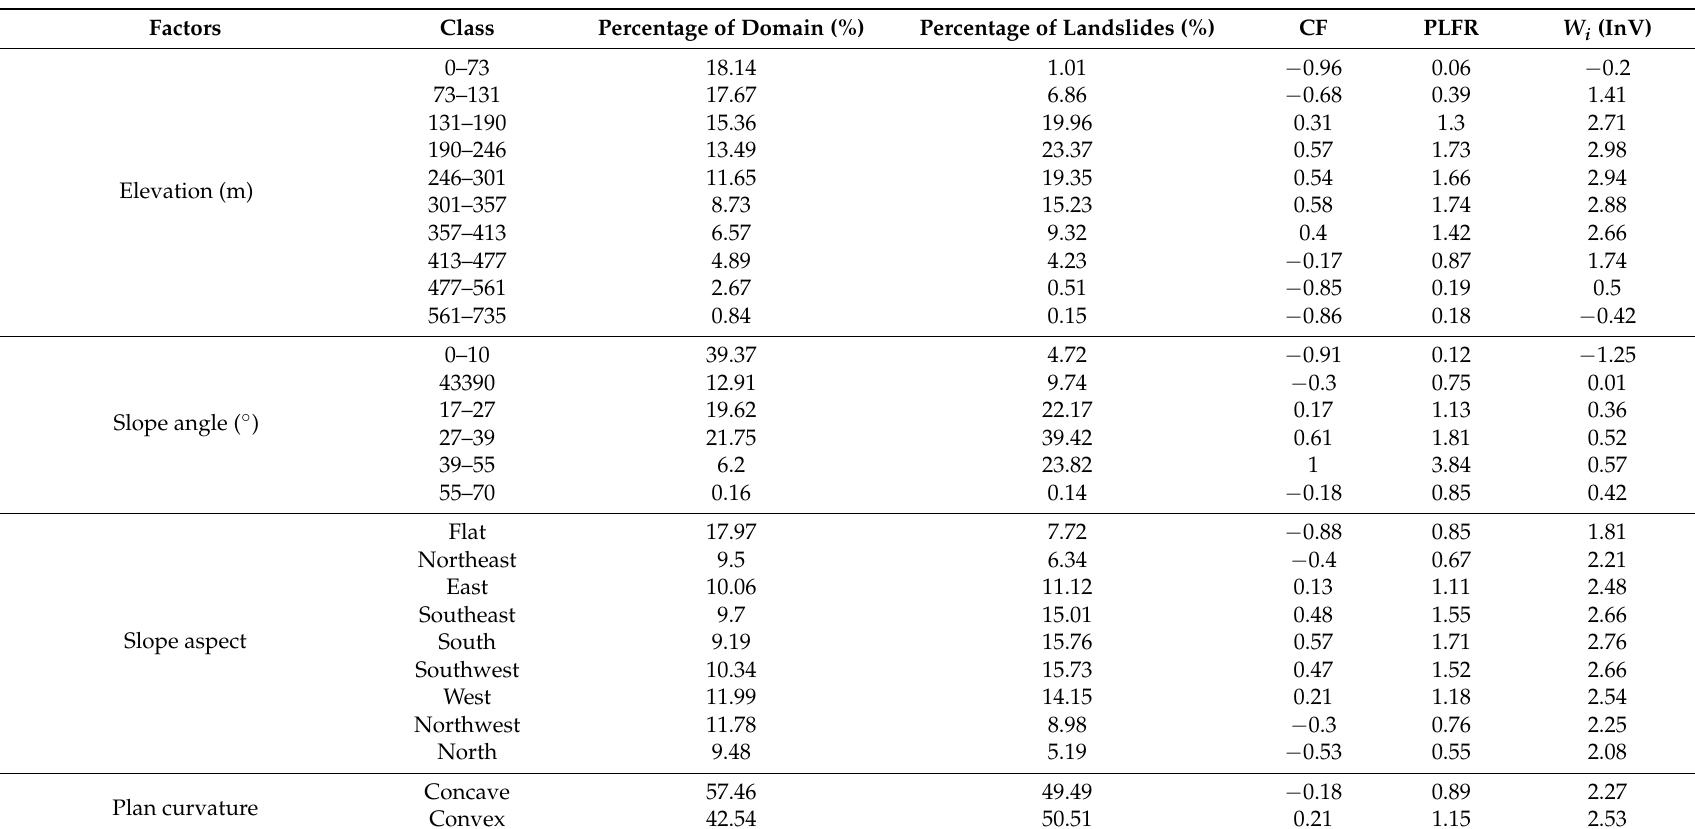
Table 6. Spatial relationship between the relative factors and landslides by CF, PLFR and InV